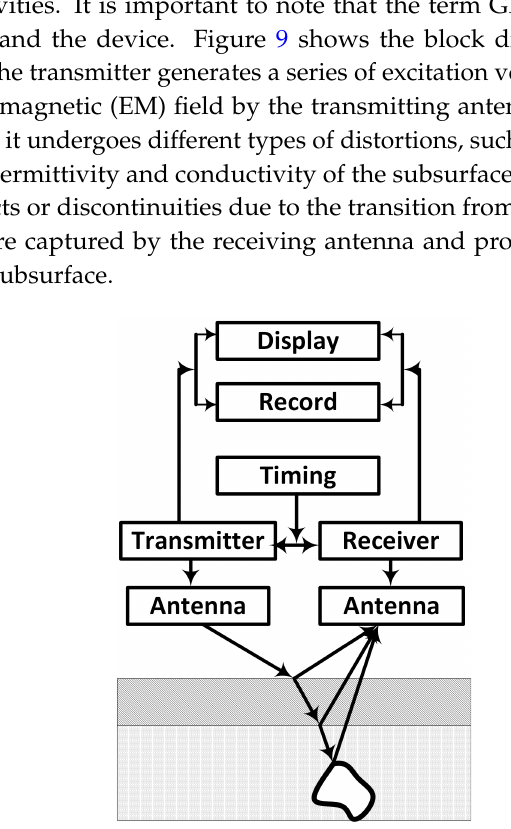
Figure 9. Block diagram of GPR operation showing reflections from different layers and an object underground. Adapted from